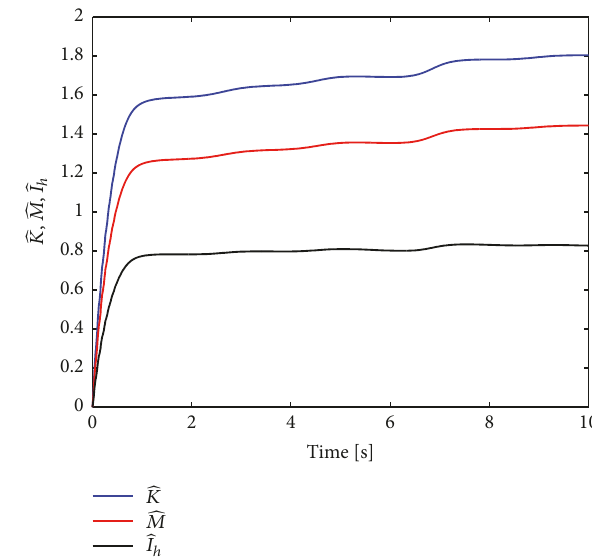
Figure 12: Estimation values of 𝐾 , 𝑀 and 𝐼 ℎ